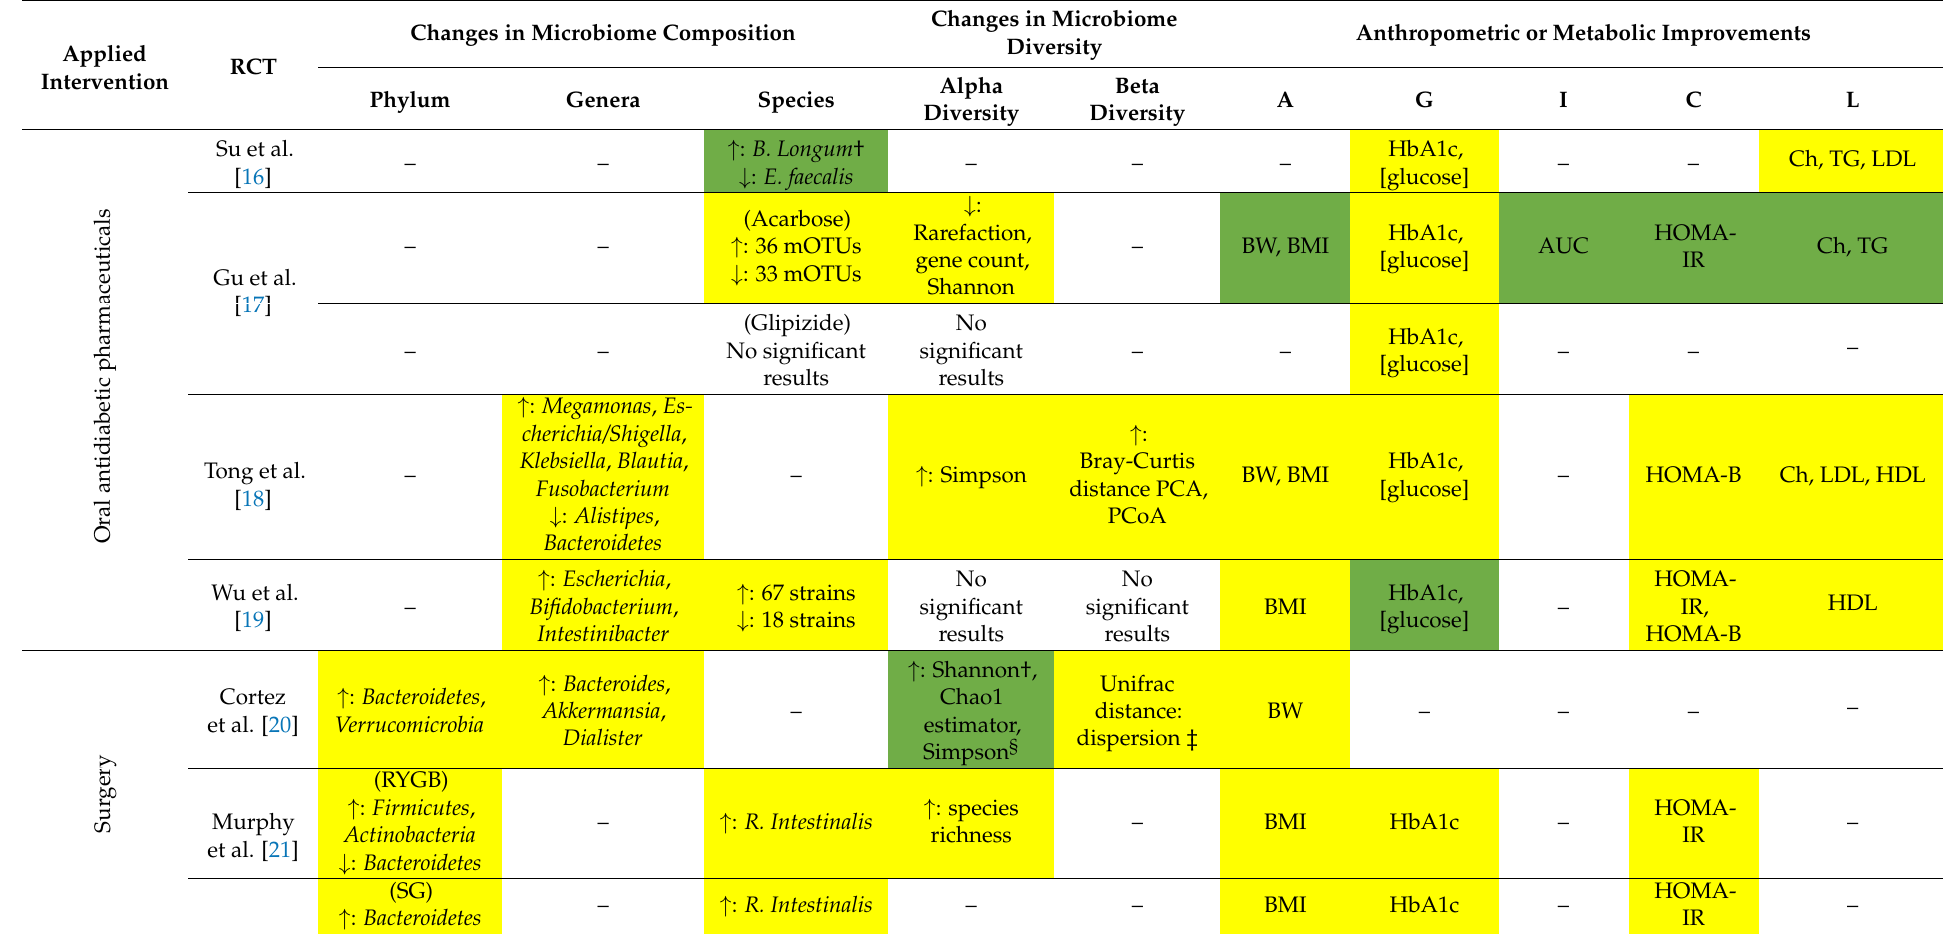
Table 2. Intervention-specific alterations in microbiome composition, biodiversity, and anthropometric or metabolic improvements.